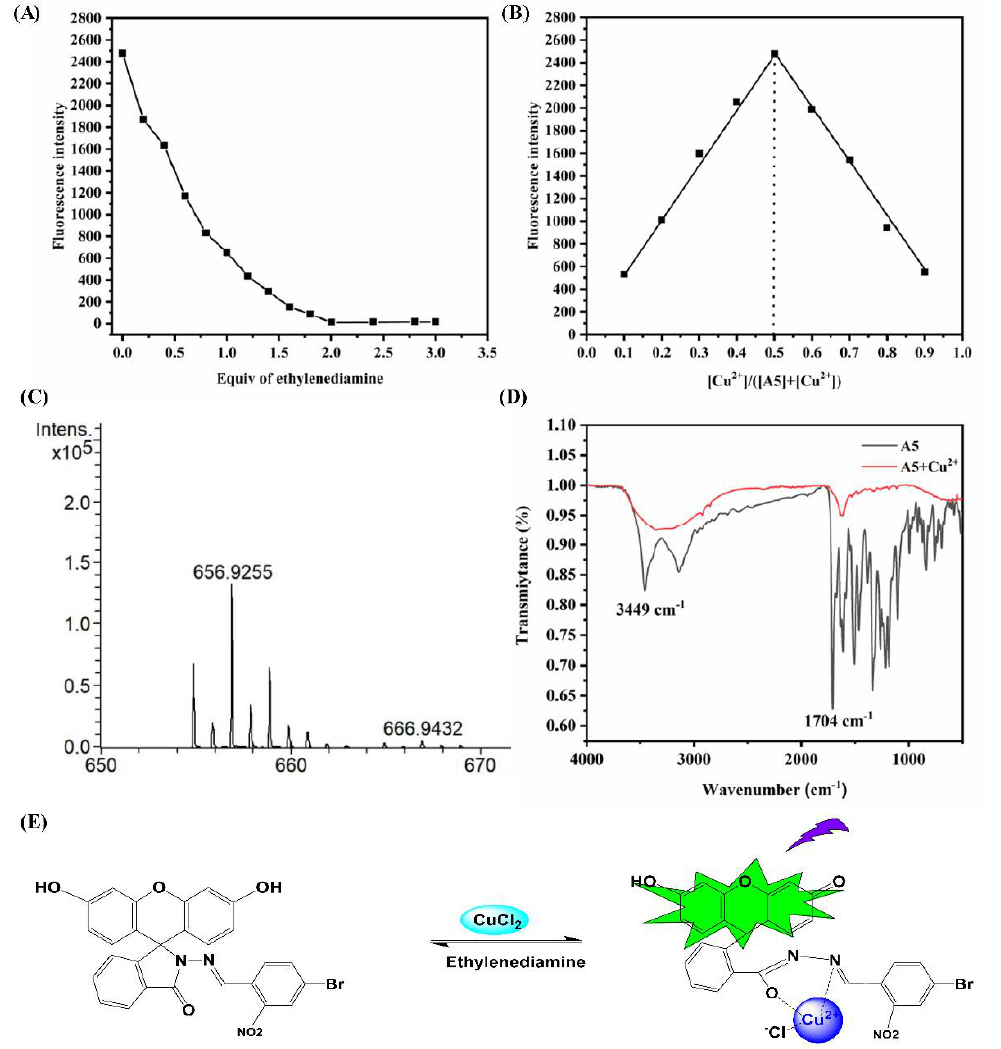
Figure 4. ( A ) The titration experiment of ethylenediamine and A5-Cu 2+ in PBS buffer (10 mM, pH = 7.4)/EtOH (1:1, v / v ), λ ex = 440 nm. ( B ) Job’s plot of A5 probe and Cu 2+ in PBS buffer (10 mM, pH = 7.4)/EtOH (1:1, v / v ), λ ex = 440 nm. ( C ) The MS analysis of A5-Cu 2+ complex. ( D ) FT-IR spectra of A5-Cu 2+ complex. ( E ) The proposed response mechanism of A5 with Cu 2+ .